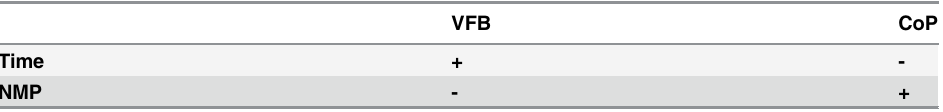
Table 1. Table of Results. VFB CoP Time + - NMP - + The effects of increased VFB fi ltering on t VFB (top left), t CoP (top right), r NMP , VFB (bottom left), and r NMP , CoP (bottom right). +: Statistically signi fi cant increase associated with increasing VFB fi ltering -: Statistically signi fi cant decrease associated with increasing VFB fi